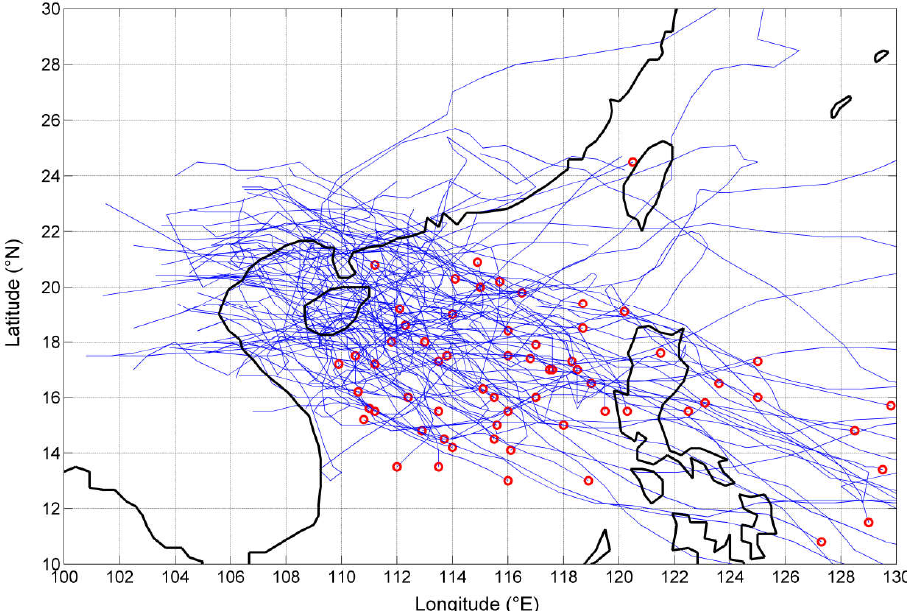
Figure 2. Typhoon tracks affecting Haidian Island. Red circles represent the origin points of typhoon events.